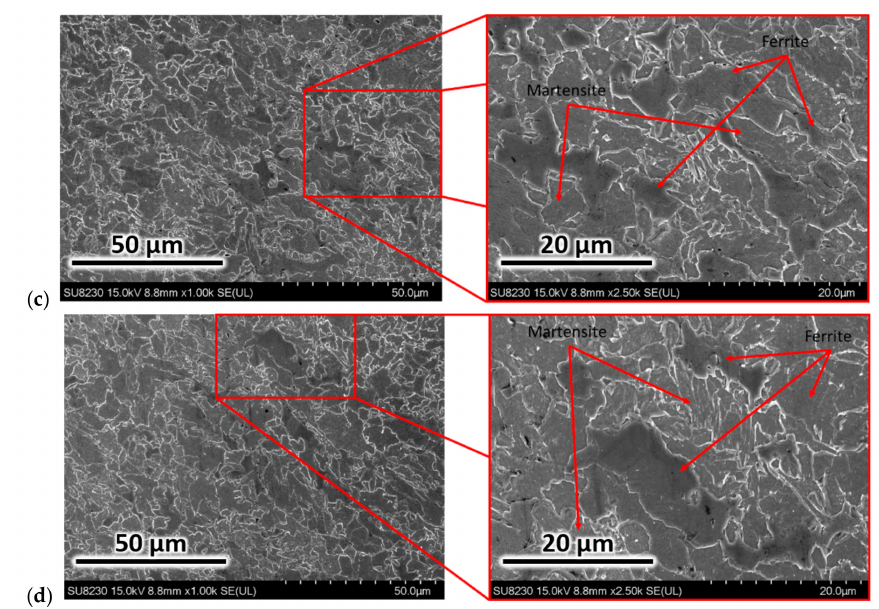
Figure 11. Microstructure of samples subjected to five finishing passes with roughing pass number of: ( a ) zero, ( b ) one, ( c ) two and ( d ) three. The images show the presence of ferrite (mostly of polygonal form) and martensite (prior austenite).